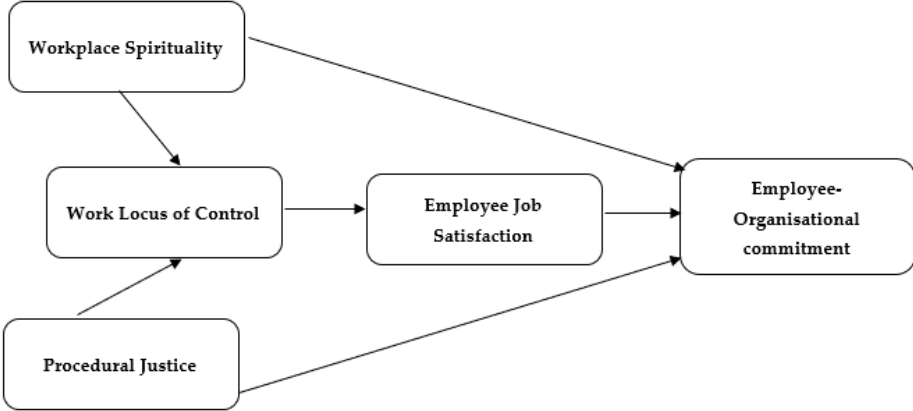
Figure 1. Theoretical model. Source: authors’ own formulation.